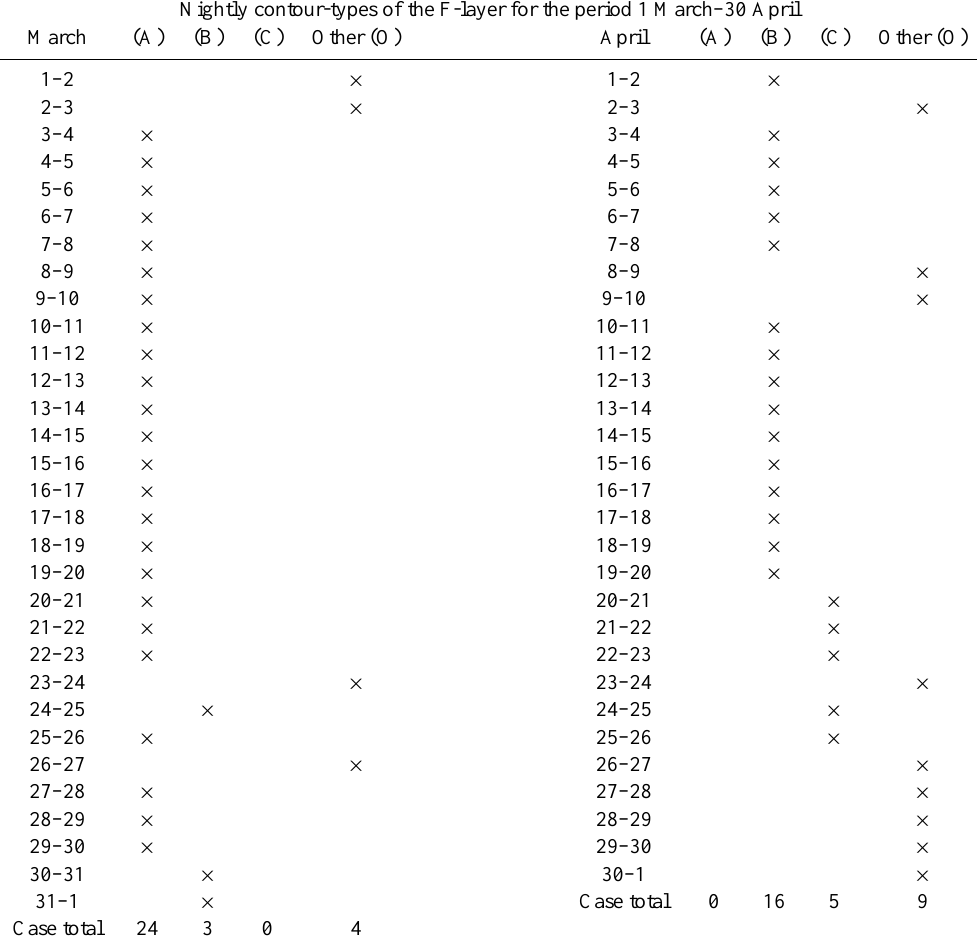
Table 2. Classification of the F-layer profiles according to their nightly patterns for the period 1 March–30 April: Type A corresponds to a single post-sunset peak (Fig. 2a), type B to a three-peak pattern including the post-sunset one (Fig. 2b) and type C to a single huge peak with a plateau region (Fig. 2c). Type O corresponds to undefined, odd